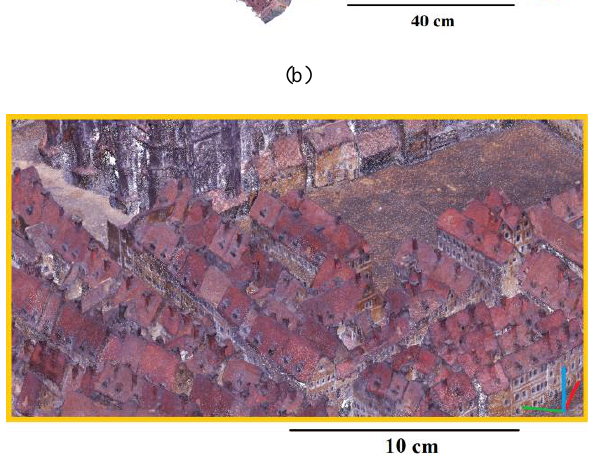
Figure 2. Photogrammetric recording from the platform